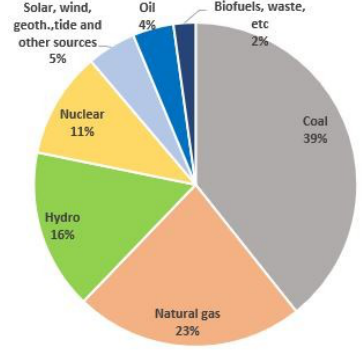
Figure 2. World electricity matrix in 2015.